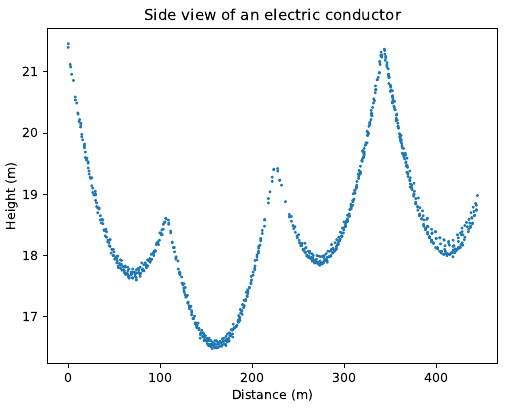
Figure 8. Side view of a catenary with several